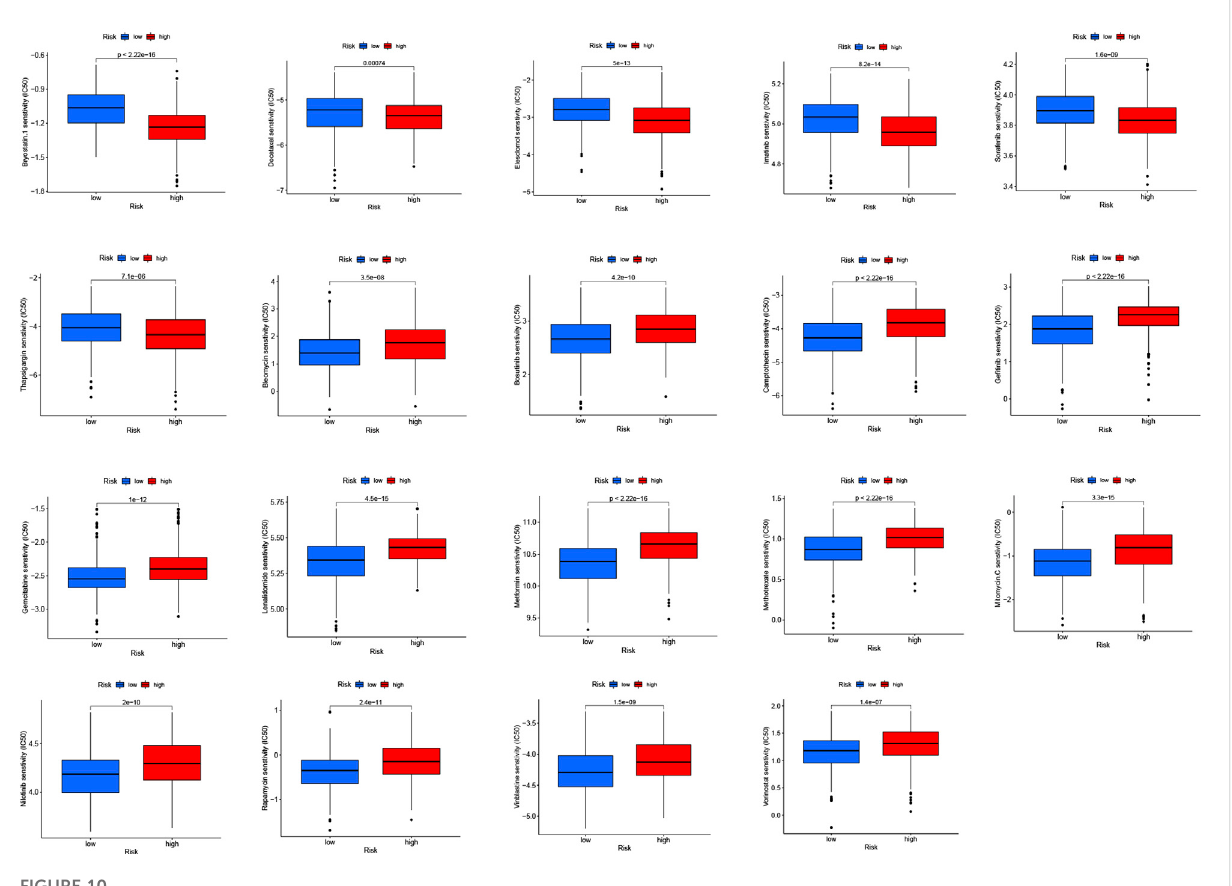
FIGURE 10 Drug susceptibility (IC50) was associated with two risk groups for